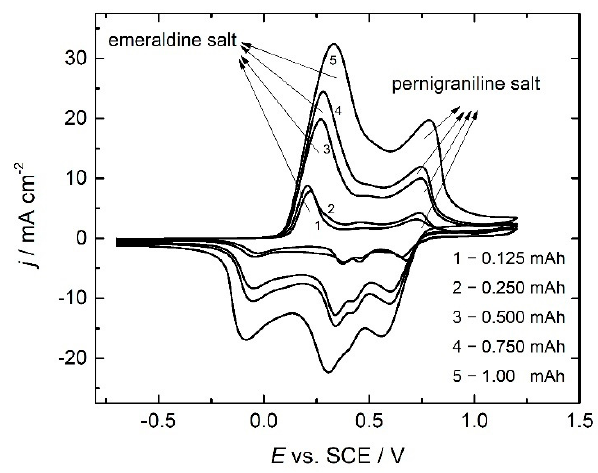
Figure 4. Cyclic voltammograms of PANI electrodes obtained with different polymerization charges (as marked in the figure) in 1.0 mol dm − 3 H 2 SO 4 at the scan rate of 20 mV s − 1 .